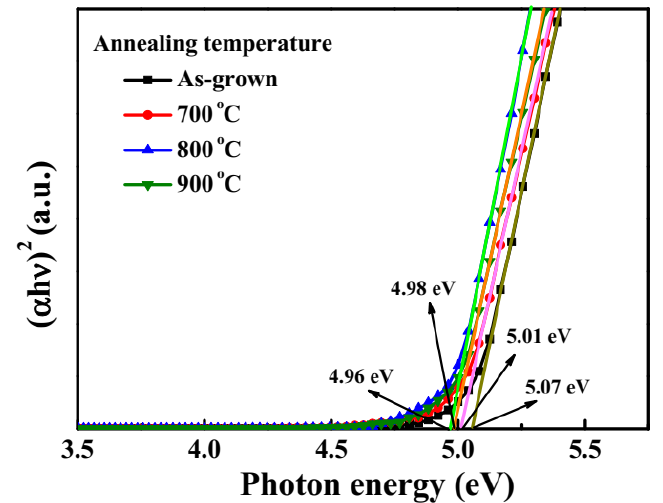
Figure 5. The ( α h υ ) 2 versus h υ characteristics of as-grown Ga 2 O 3 films and Ga 2 O 3 films annealed at various